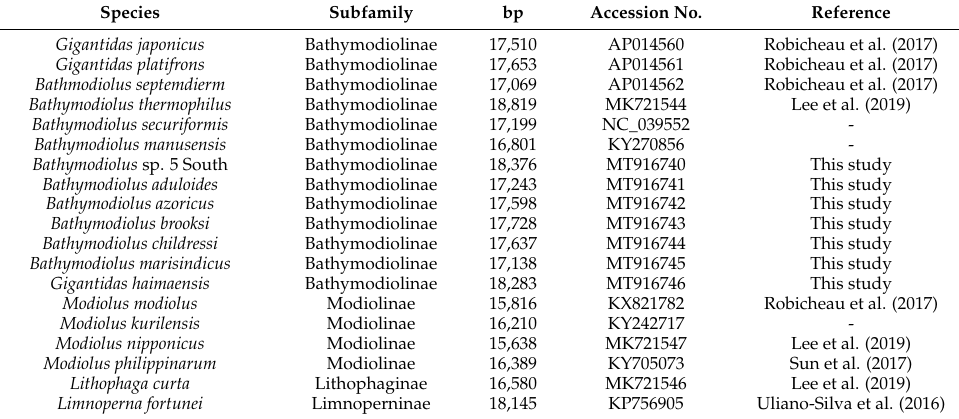
Table 1. Complete mitochondrial genomes used for phylogenetic analysis in this